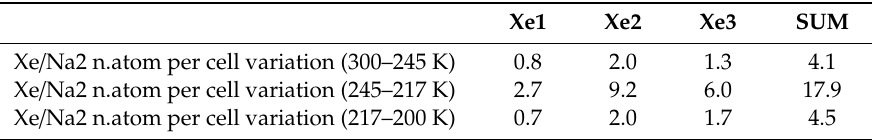
Table 1. Xe / Na2 no. of atoms per cell